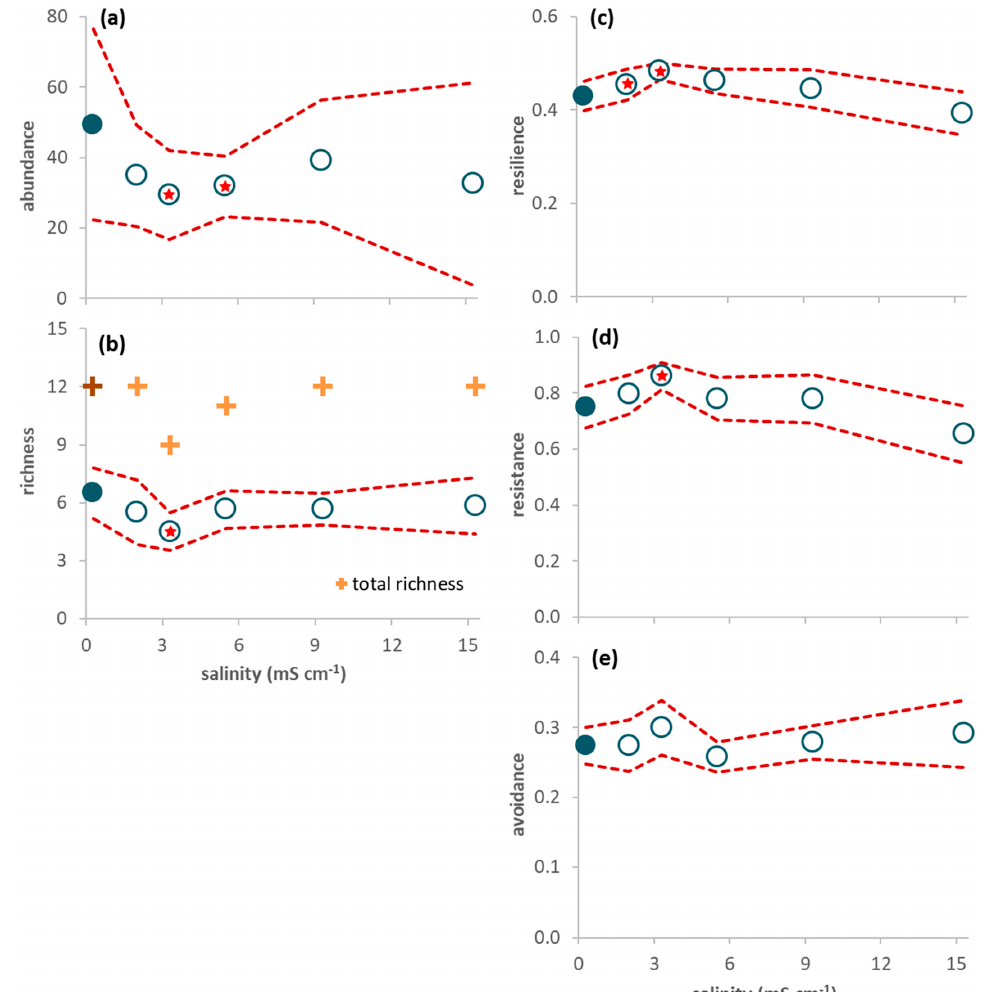
Figure 3. Response variables of the invertebrates sampled in the mesocosms during the 65-day period (average per sample ± 95% confidence limits (red dashed line); n = 6). ( a ) Invertebrate abundance; ( b ) Invertebrate richness (plus symbols refer to total (instead of average) richness: dark color for the control and light color for the treatments); ( c ) Proportion of resilience traits (short lifespan, ovoviviparous reproduction, and aerial respiration); ( d ) Proportion of resistance traits (multivoltinism); ( e ) Proportion of avoidance traits (non-aquatic life stages and terrestrial reproduction). A red star indicates a net average deviation of the values in a treatment (open circles) in relation to the values in the control (close circles) according to Table 2.